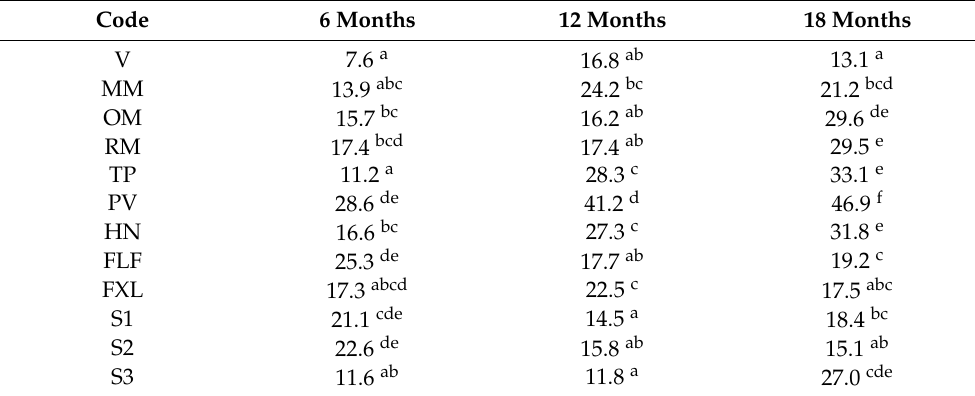
Table 5. Games–Howell pairwise mean differences of color change for red alder wood during each interval of the study. Letters in superscripts indicate the treatment groups with means that are not significantly different at the p < 0.05